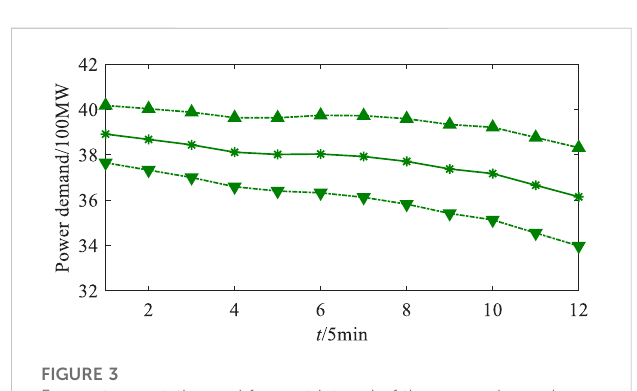
FIGURE 3 Forecast expectation and forecast interval of the power demand.